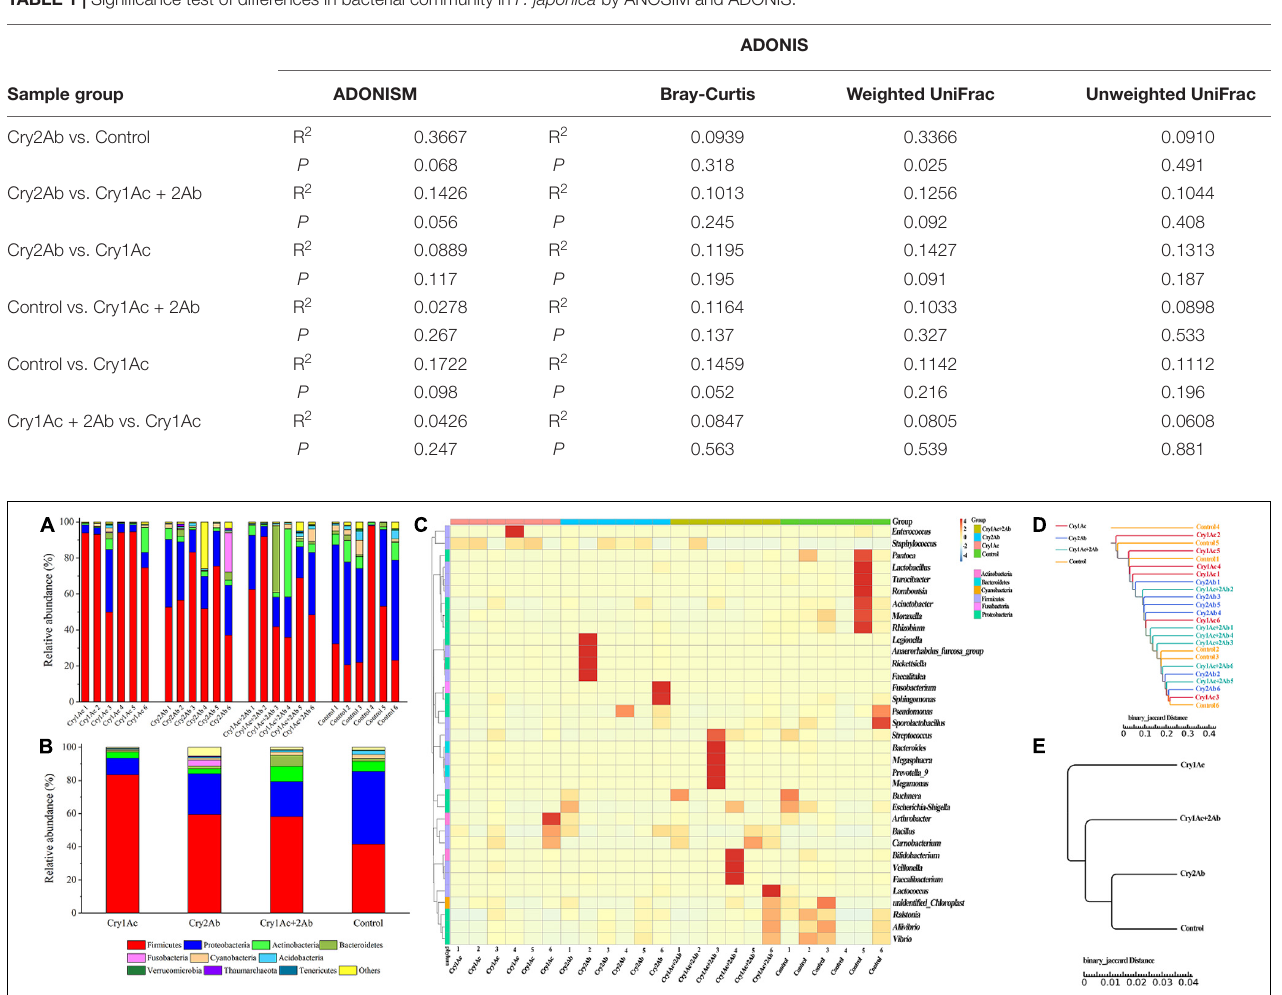
FIGURE 2 | Bacterial composition of P. japonica in response to consumption of Bt toxins. Relative abundance of the dominant bacterial species found in P. japonica at the phylum level of each sample (A) and group (B) . Heatmap showing the relative abundance of dominant taxa at the genus level in each sample (C) . A dendrogram was prepared using the binary Jaccard distance to compare the similarity of the bacterial communities between samples (D) and groups (E) .